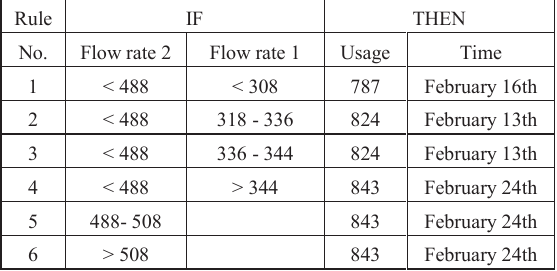
Table 11. Decision tree rules for Stage 2 - Case2